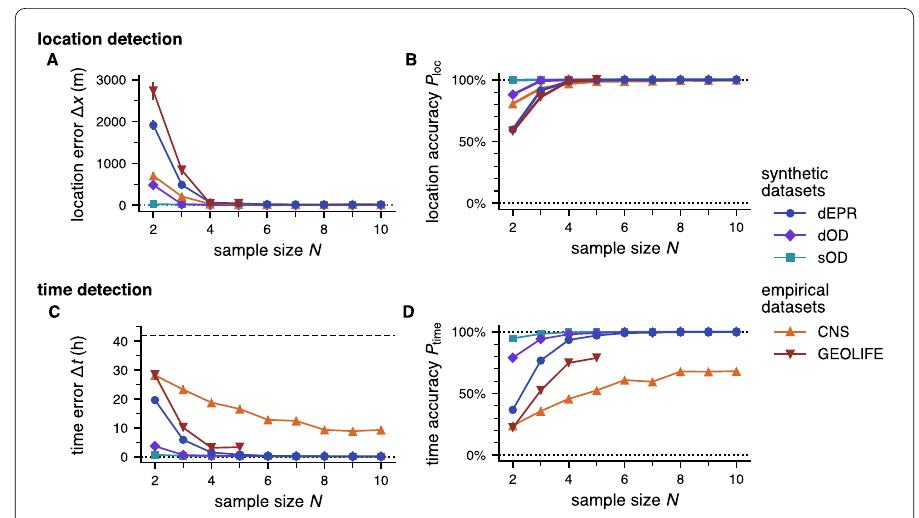
Figure 2 Accuracy of the outbreak detection, depending on the number of individuals N in the sample. In these and further plots, results are averaged over 1000 measurements for each dataset and sample size N . Error bars indicate the standard error. A The distance error (cid:4) x between true and estimated location decreases quickly with growing sample size N . B The method is able to infer the correct outbreak location with high accuracy P loc , even for a small number of input trajectories. C The temporal error (cid:4) t decreases fast for the synthetic datasets, but less so for the empirical datasets, which we attribute to repeated behavioral patterns in the datasets’ populations (see main text). The dashed line at (cid:4) t = 42 h marks the expected error for a random guess of the outbreak time within the sample interval of 7 days. D The accuracy P time of the time inference increases more slowly, and the accuracy is generally lower for the empirical datasets, which we again attribute to repeated behavioral